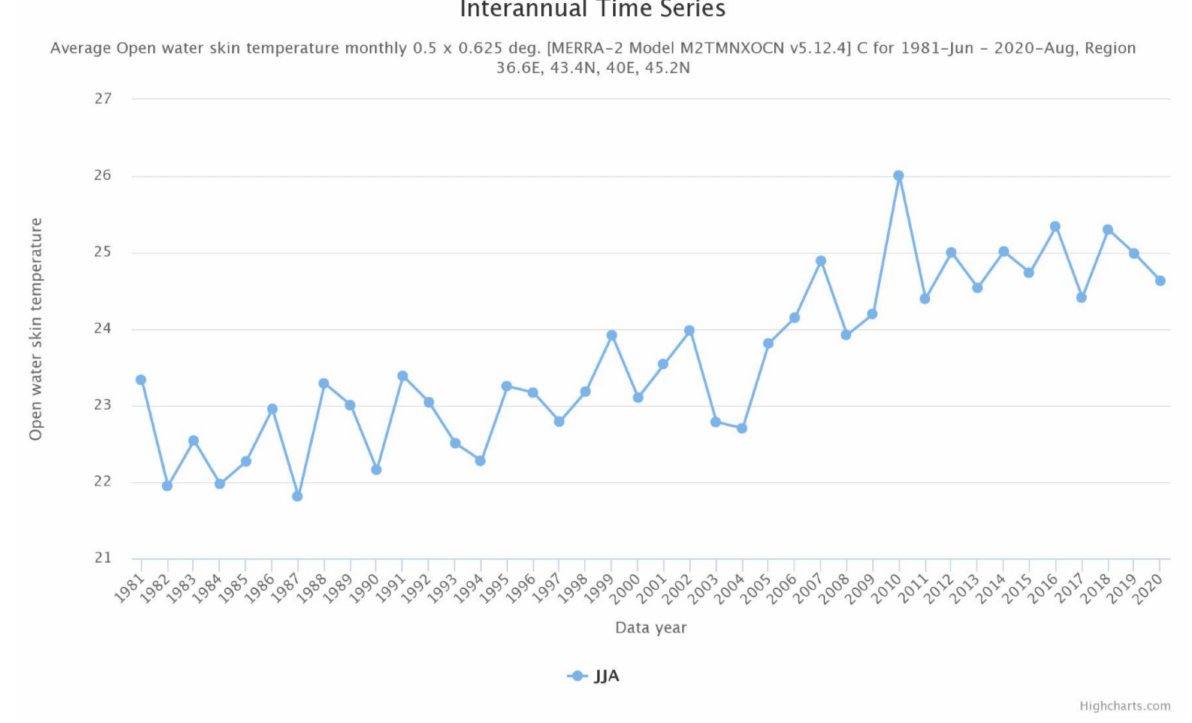
Figure 5. Interannual variability of the sea surface temperature in the northeastern Black Sea during summer from 1981–2020 based on the MERRA-2 M2TMNXOCN V5.12.4